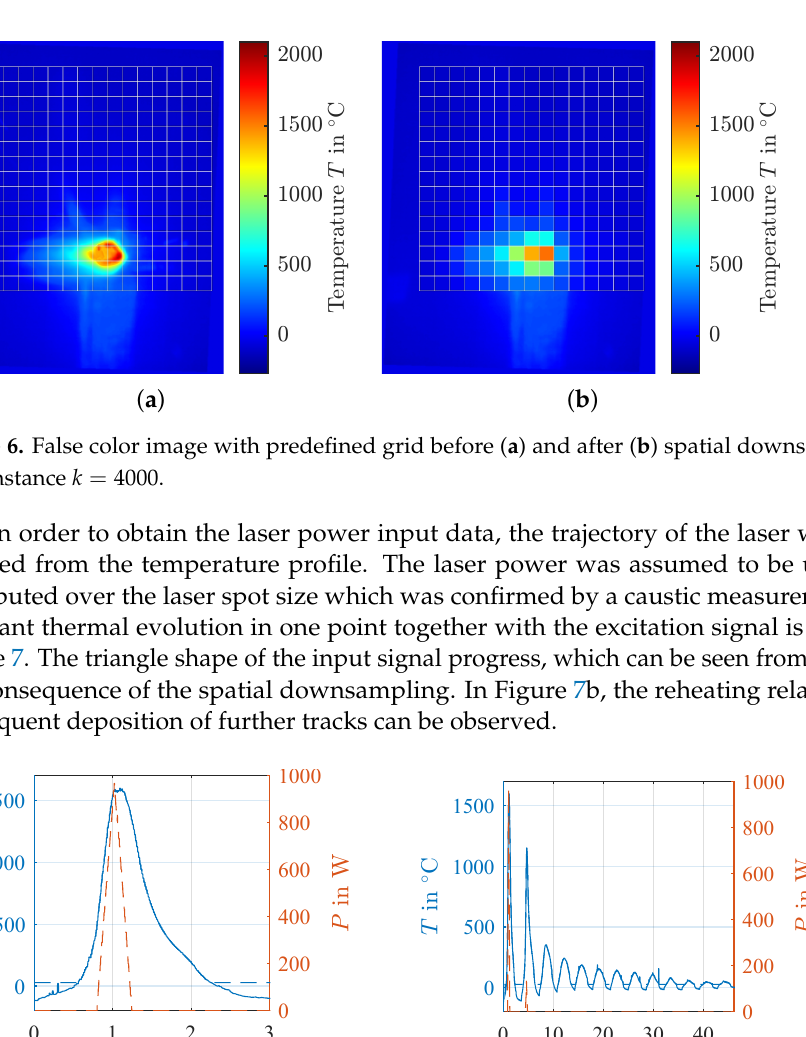
Figure 5. Resultant false color image of the specimen for time instance at the end of the build process.